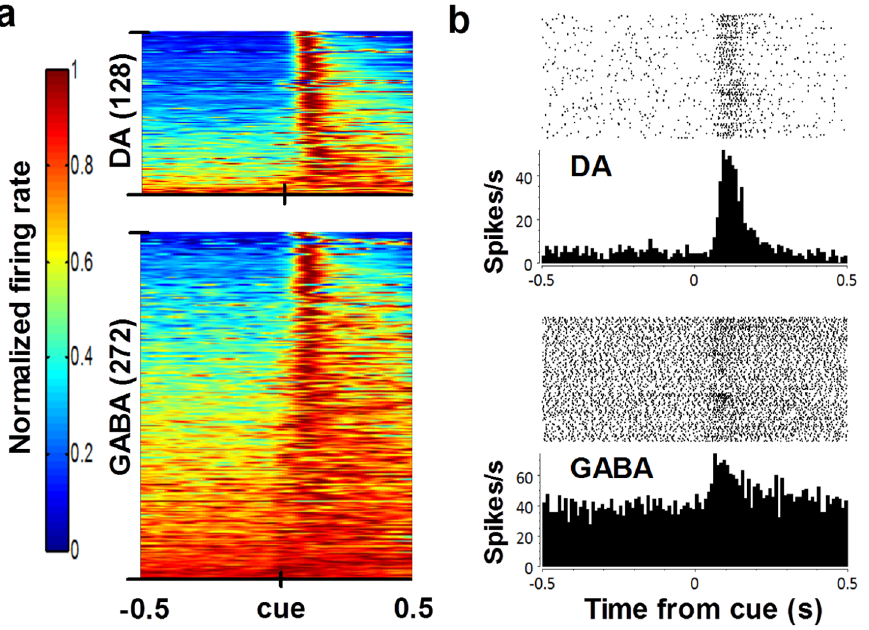
Figure 3. Dopaminergic and GABAergic neurons showed a phasic response to reward cue. ( a ) Activity of neurons that increased following reward cue normalized to the maximum firing rate; sorted according to increasing cumulative maximum values. Each row represents one neuron. X axis is time from reward cue onset (s). n is indicated in parentheses. ( b ) Representative peri-event histograms and rasters for individual DA (top) and GABA (bottom) neurons showing phasic responses following the reward cue (10 ms bins).